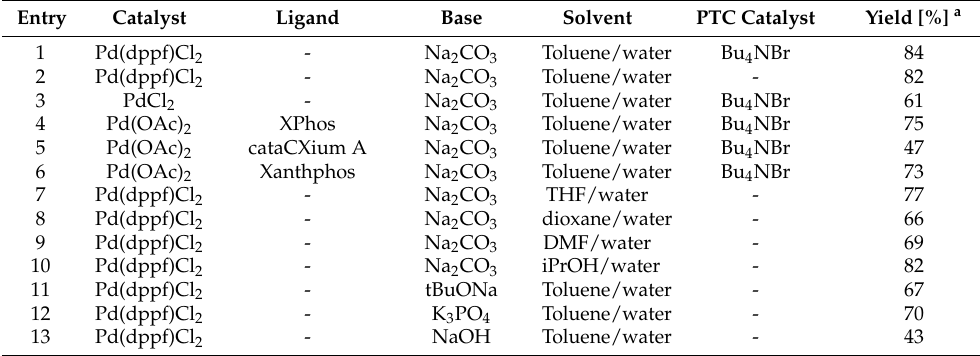
Table 1. Optimization of the Suzuki cross-coupling reaction to obtain 8a